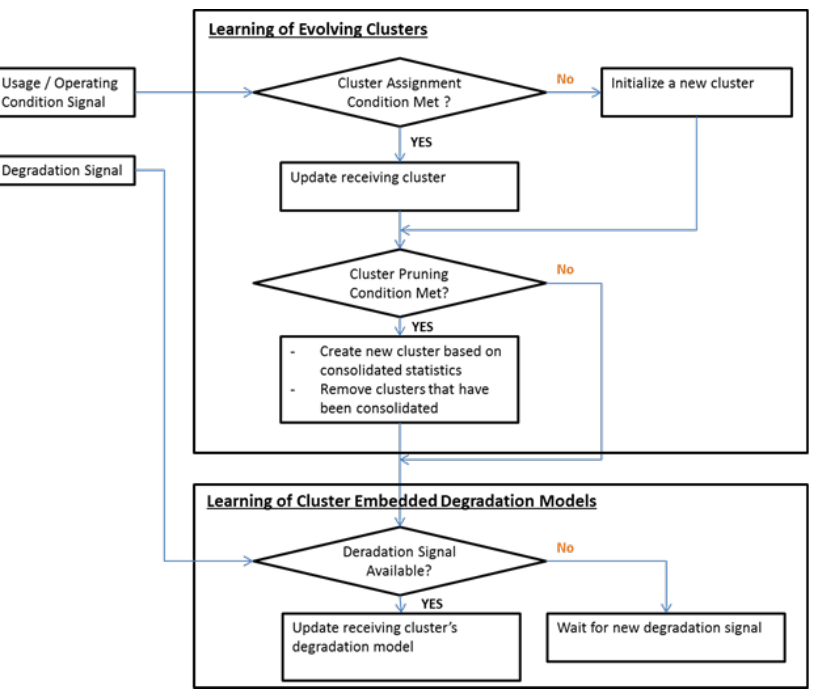
Chart 1. Flowchart of evolving clustering with embedded local (survival/degradation) functions for system